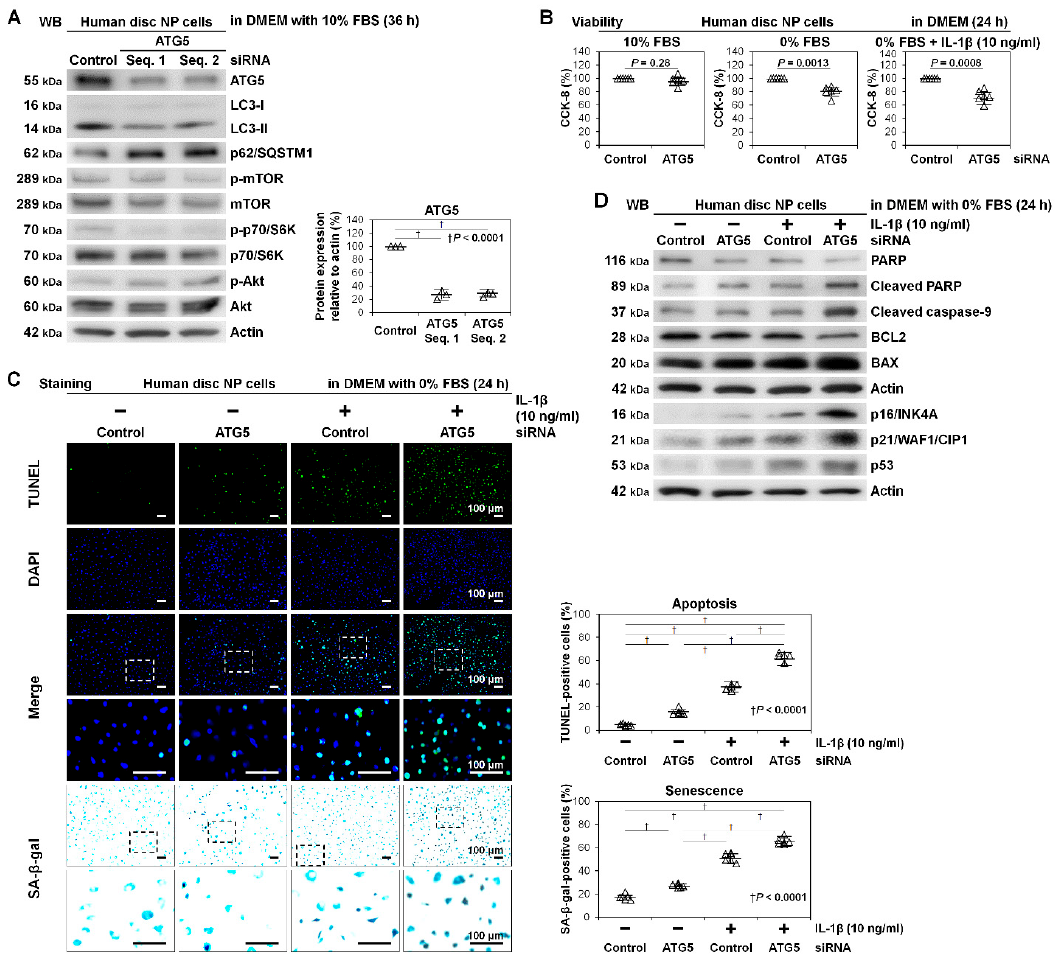
Figure 3. Decreased viability with induced apoptosis and senescence by autophagy inhibition through ATG5 knockdown in human disc NP cells. ( A ) Western blotting for autophagic ATG5, LC3, and p62/SQSTM1 and mTOR signaling-related mTOR, phosphorylated mTOR, p70/S6K, phosphorylated p70/S6K, Akt, and phosphorylated Akt in total protein extracts from human disc NP cells after a 36 h transfection of ATG5 siRNA with two different sequences or non-targeting siRNA in DMEM with 10% FBS. Actin was used as a loading control. Immunoblots shown are representative of experiments with similar results ( n = 3). Changes in protein expression of ATG5 (normalized to actin) in ATG5 RNAi treatment relative to non-targeting siRNA-transfected control are shown. Data are the mean ± 95% CI. † p < 0.0001. One-way repeated-measures ANOVA and the Tukey-Kramer post-hoc test were used ( n = 3). ( B ) Cell viability of human disc NP cells using CCK-8 after a 36 h transfection of ATG5 or non-targeting siRNA in DMEM with 10% FBS followed by 24 h culture in serum-supplemented DMEM with 10% FBS, serum-free DMEM with 0% FBS, or serum-free DMEM with 0% FBS and 10 ng/mL IL-1 β . Changes in CCK-8 dehydrogenase activity of ATG5 RNAi treatment relative to non-targeting siRNA-transfected control are shown. Data are the mean ± 95% CI. A paired t -test was used ( n = 6). ( C ) Fluorescence for apoptotic TUNEL (green), nuclear DAPI (blue), and merged signals and cytochemistry for senescent SA- β -gal in human disc NP cells after a 36 h transfection of ATG5 or non-targeting siRNA in 10% FBS-supplemented DMEM followed by culturing for 24 h in serum-free DMEM with or without 10 ng/mL IL-1 β . The fluorescent and cytochemical images shown are representative of experiments with similar results ( n = 6). Changes in the percentage of TUNEL-positive cells in DAPI-positive cells and of SA- β -gal-positive cells in total cells are shown. The number of cells was counted in six random low-power fields ( × 100). Data are the mean ± 95% CI. † p < 0.0001. One-way repeated-measures ANOVA and the Tukey–Kramer post-hoc test were used ( n = 6). ( D ) Western blotting for pro-apoptotic cleaved PARP, cleaved caspase-9, and BAX, anti-apoptotic PARP and BCL2, pro-senescent p16/INK4A, p21/WAF1/CIP1, and p53, and loading control actin in total protein extracts from human disc NP cells after a 36 h transfection of ATG5 or non-targeting siRNA in 10% FBS-supplemented DMEM followed by 24 h culture in serum-free DMEM with or without 10 ng/mL IL-1 β . Immunoblots shown are representative of experiments with similar results ( n =